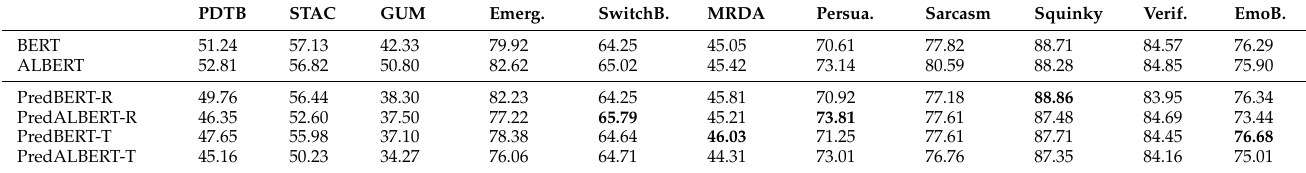
Table 2. Results in the PragmEval benchmark for our models in English. The metric is accuracy for all tasks. We perform the evaluation three times with different initial